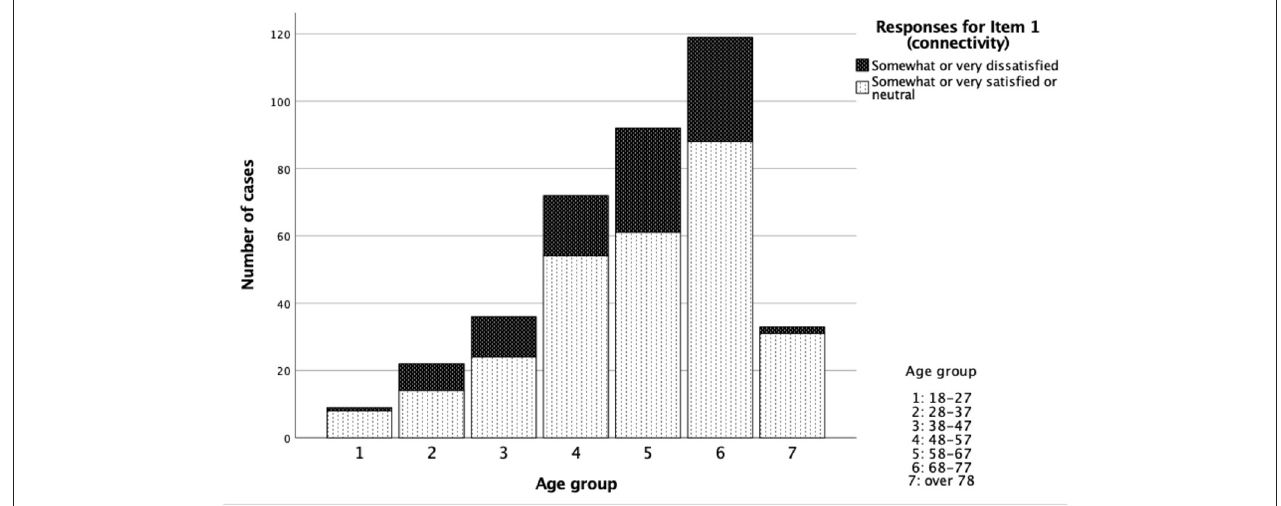
FIGURE 4 | Satisfaction with Item 1 (connectivity) by age.